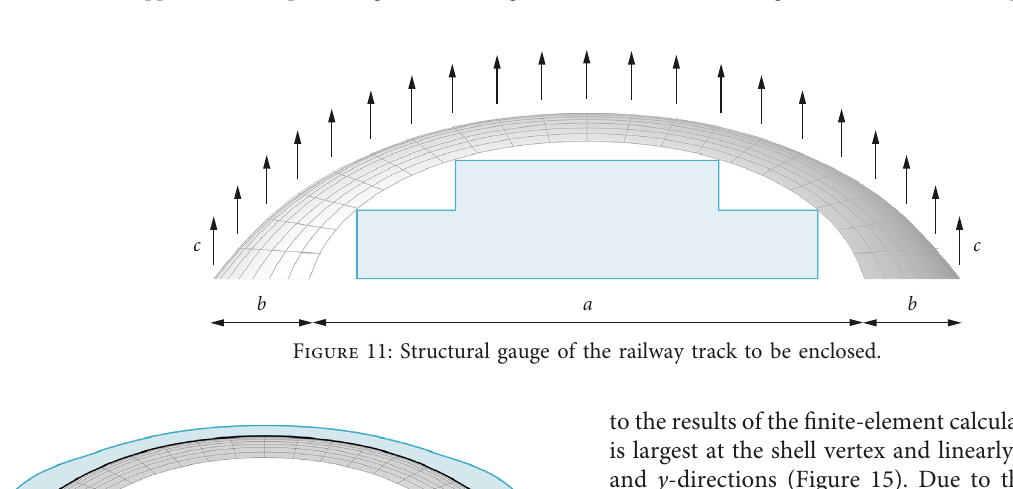
Figure 10: Applied forces representing shell self-weight, vertical earth load (orange), and horizontal earth pressure (blue).